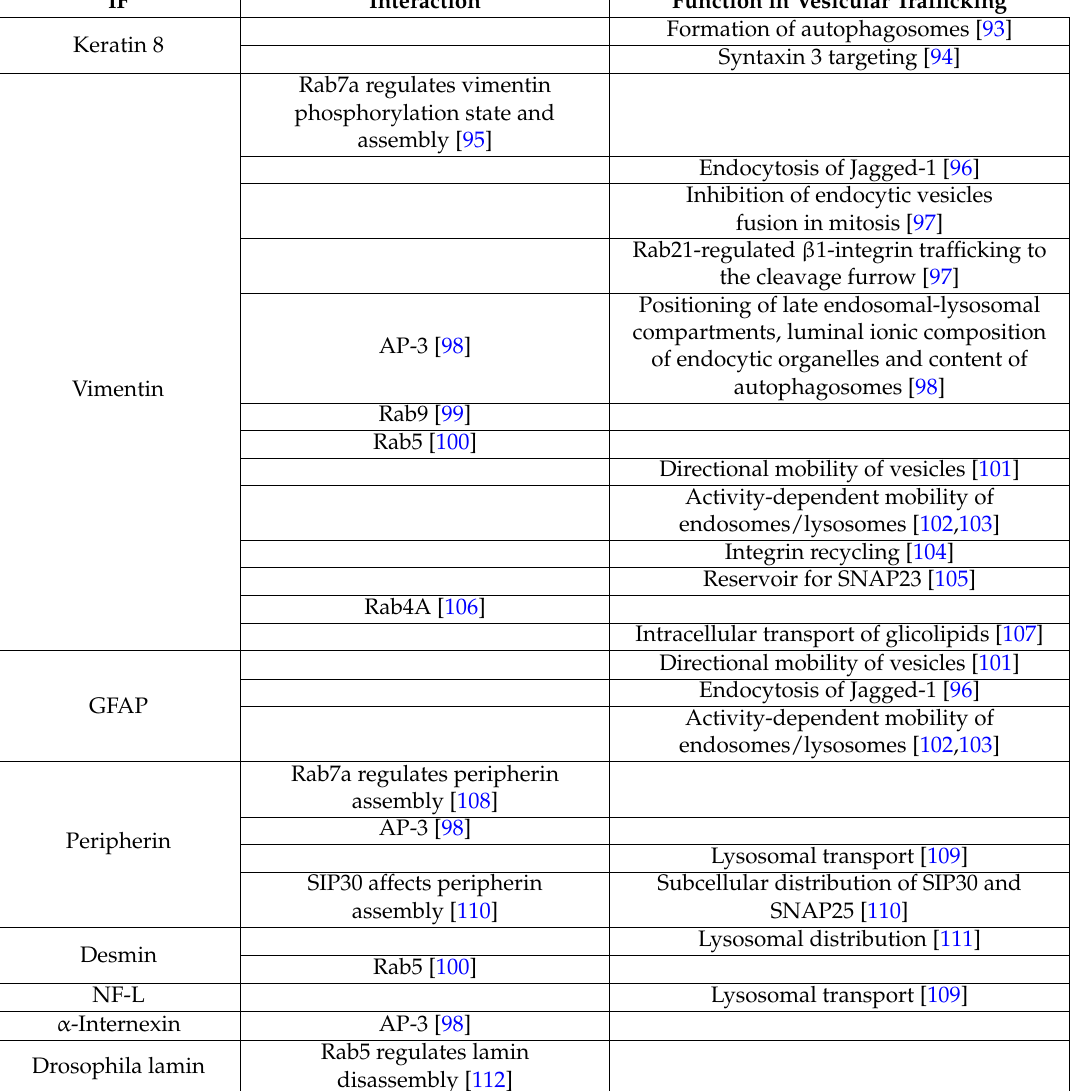
Table 1. List of links between IFs and the vesicular membrane transport machinery. IF Interaction Function in Vesicular Trafficking Formation of autophagosomes [93] Keratin 8 Syntaxin 3 targeting [94] Rab7a regulates vimentin phosphorylation state and assembly [95] Endocytosis of Jagged-1 [96] Inhibition of endocytic vesicles fusion in mitosis [97] Rab21-regulated β 1-integrin trafficking to the cleavage furrow [97] Positioning of late endosomal-lysosomal compartments, luminal ionic composition AP-3 [98] of endocytic organelles and content of autophagosomes [98] Vimentin Rab9 [99] Rab5 [100] Directional mobility of vesicles [101] Activity-dependent mobility of endosomes/lysosomes [102,103] Integrin recycling [104] Reservoir for SNAP23 [105] Rab4A [106] Intracellular transport of glicolipids [107] Directional mobility of vesicles [101] Endocytosis of Jagged-1